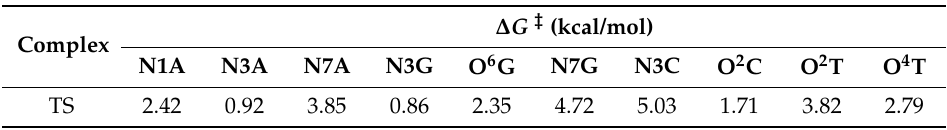
Table 1. Free energy barriers of the transition states for alkylation reactions with ten DNA base sites induced by the 2 (cid:48) -hydroxylation diazonium ion a